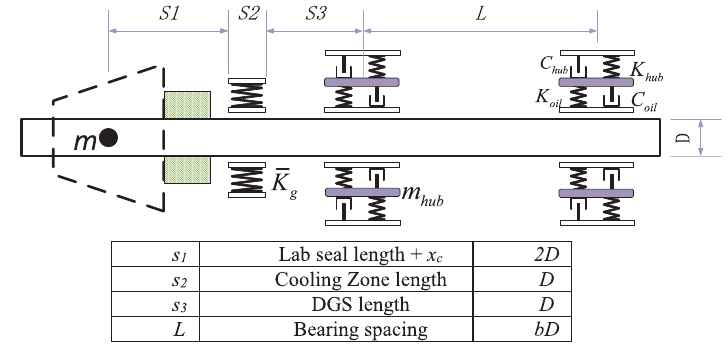
Fig. 2. Approximate rotor